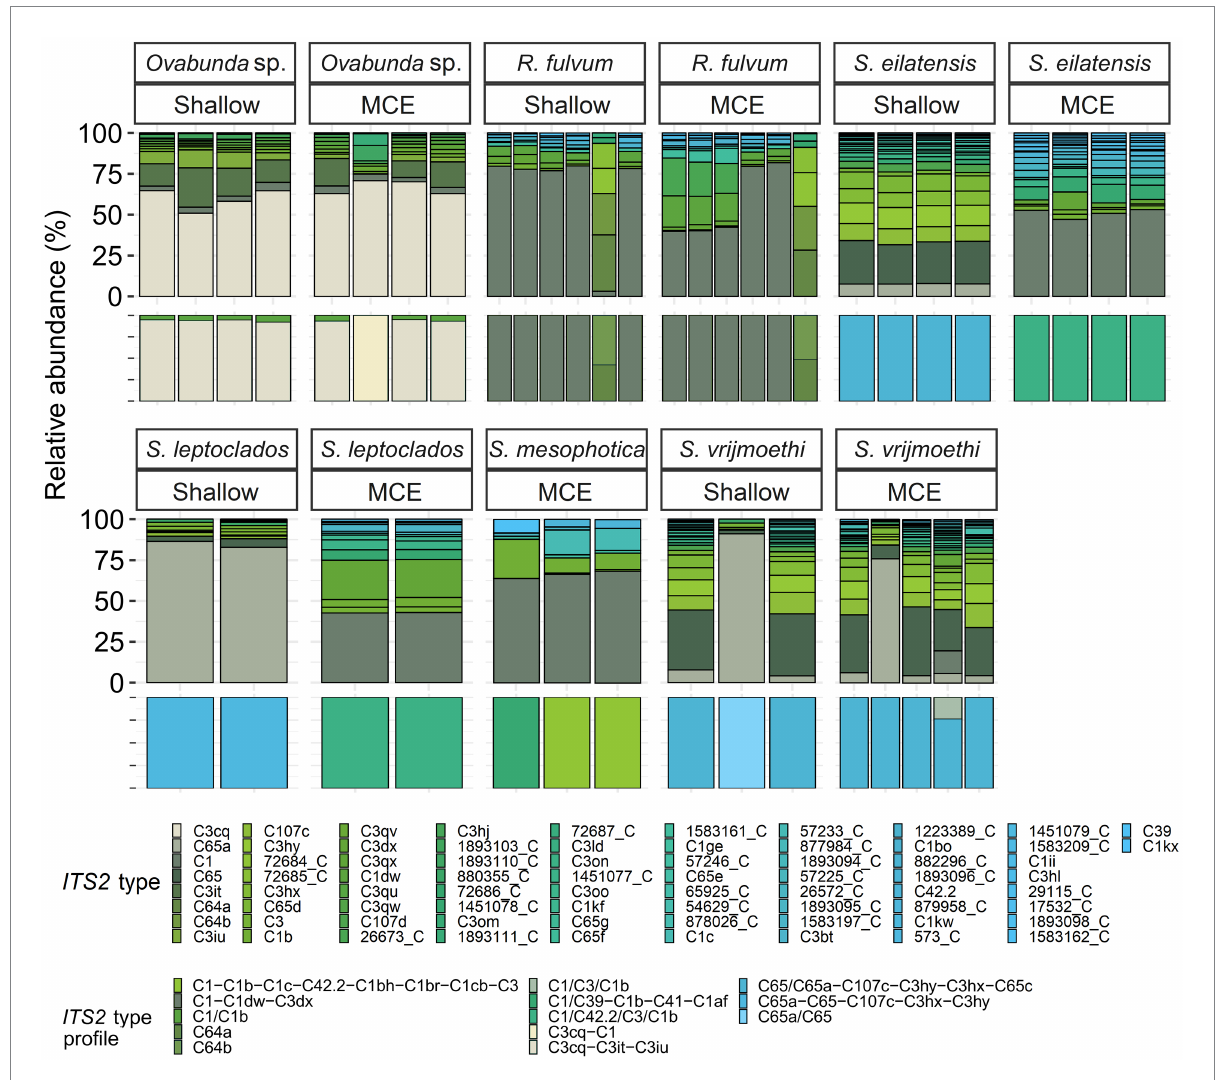
FIGURE 5 Normalized relative abundance of members of Cladocopium in octocoral host species from shallow and mesophotic reefs in the Gulf of Aqaba/ Eilat. Relative abundances of ITS2 sequences and predicted ITS2 type-profiles (above and below, respectively) arranged by octocoral taxon and depth zone. Only the >0.01% most abundant sequences are displayed ( n = 74). Sequences not used in the definition of ITS2 type profiles are given a unique database ID number followed by a letter referring to the genus the sequence is from (e.g., 29,115_C is a sequence from the genus Cladocopium with the database ID 29115). Type-profile names are listed according to the sequence of their abundance, with ‘/’ separating type- sequences with co-dominance in a given sample. R., Rhytisma; S., Sinularia